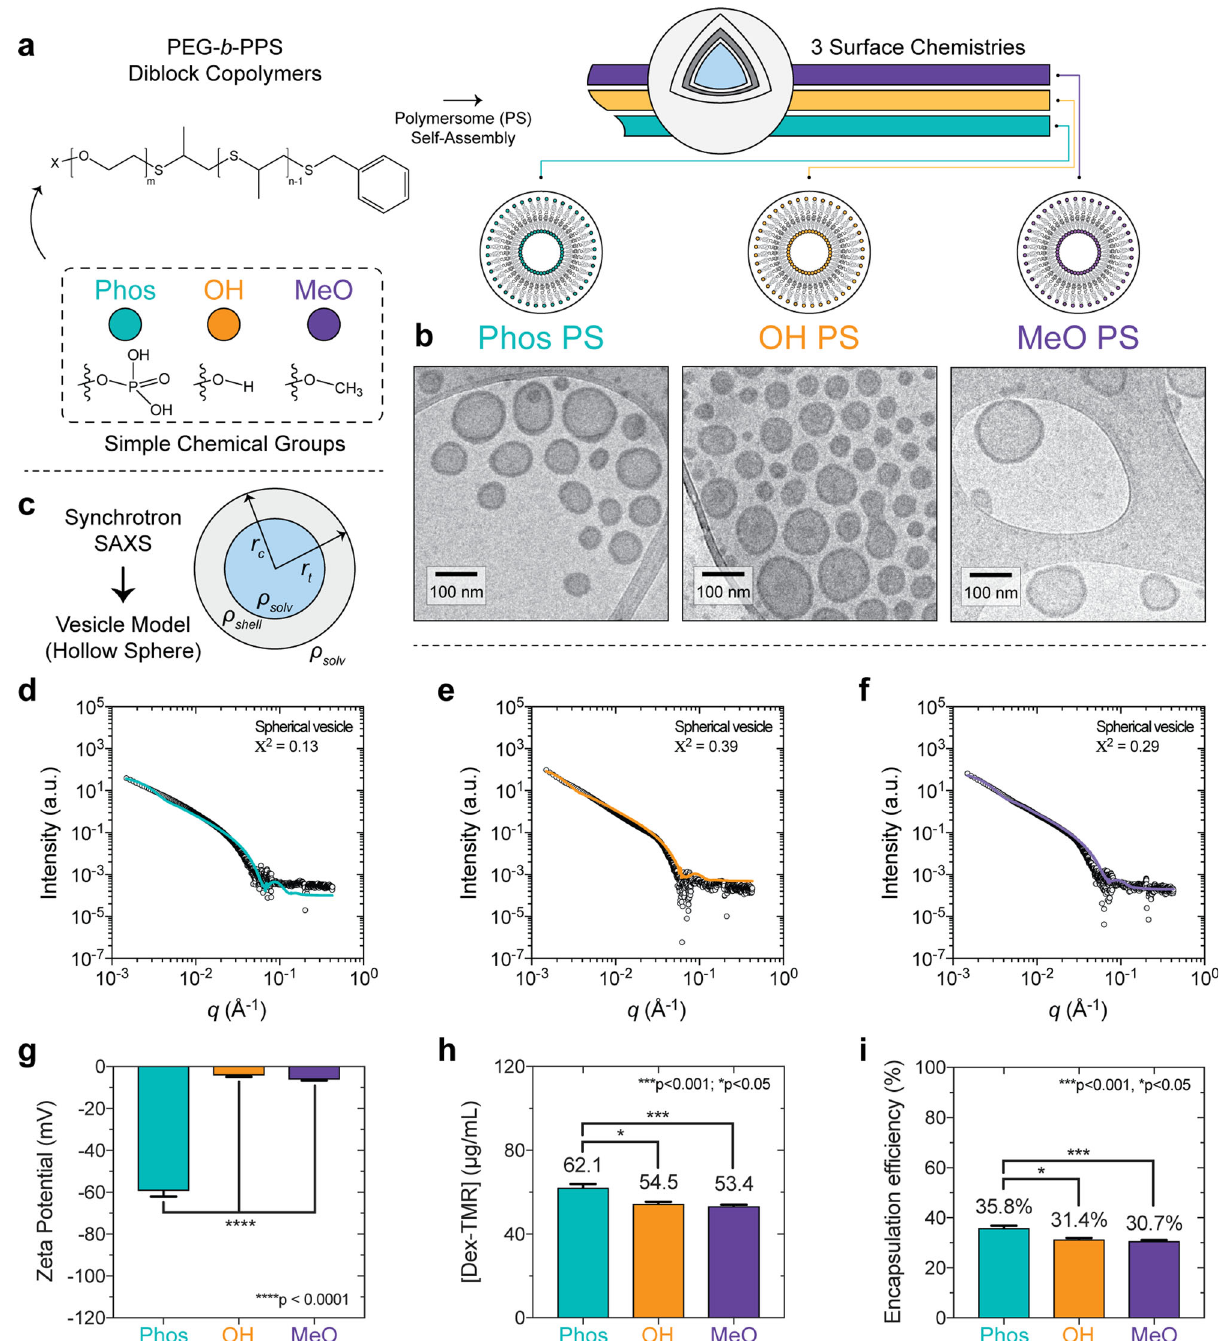
Fig. 1 PEG- b -PPS polymersome morphology and hydrophilic loading characterization. a Illustration depicting the poly(ethylene glycol)- b -poly(propylene sul fi de) (PEG- b -PPS) polymersomes (PS) of three different surface chemistries. b Cryo-TEM of Phos PS, OH PS, and MeO PS. TEM micrographs were acquired at ×10,000 magni fi cation (scale = 100 nm). c Illustration of PS characterization by small angle x-ray scattering (SAXS). A schematic of the spherical vesicle model is shown (core radius, r c ; total radius, r t ; scattering length density of the solvent and shell, ρ solv and ρ shell , respectively). d – f SAXS scattering pro fi les and fi t models for blank d Phos PS, e OH PS, and f MeO PS nanocarriers. SAXS was performed using synchrotron radiation. In each case, the scattering pro fi le (gray dots) was fi t using a spherical vesicle model. The model fi t is represented as a solid line. The intensity (arbitrary units; a.u.) is plotted with the scattering vector ( q ). The chi square ( X 2 ) for each model fi t is displayed. A X 2 value of <1.0 indicates a reasonable model fi t. g Zeta potential (mV) of Phos PS, OH PS, and MeO PS. The mean ± s.d. (n = 3) is displayed. h , i , Loading of the high molecular weight hydrophilic cargo. h The concentration of encapsulated 70 kDa Dextran-TMR (Dex-TMR) after purifying PS with size exclusion chromatography. i Dex-TMR encapsulation ef fi ciency. For h , i , error bars represent s.e.m. from three parallel experiments ( n = 3). In all cases, signi fi cance was determined by ANOVA with post hoc Tukey ’ s multiple comparisons test (5% signi fi cance level). * p < 0.05, *** p < 0.001, **** p < 0.0001.